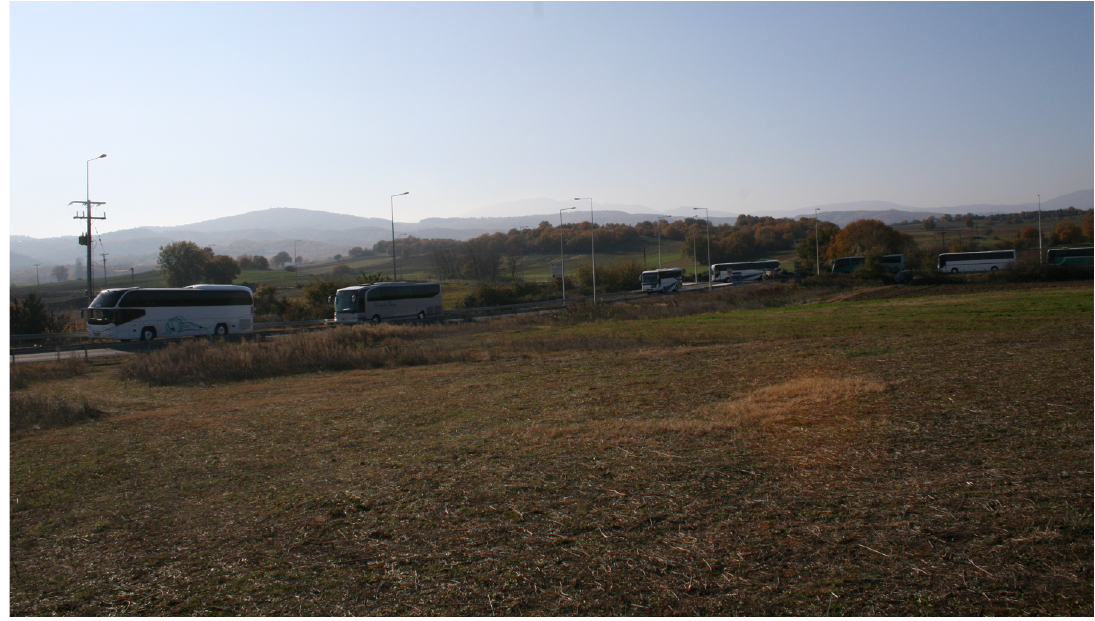
Figure 19. Buses carrying refugees depart from the refugee camp at Idomeni after its evacuation (photo Stamatis